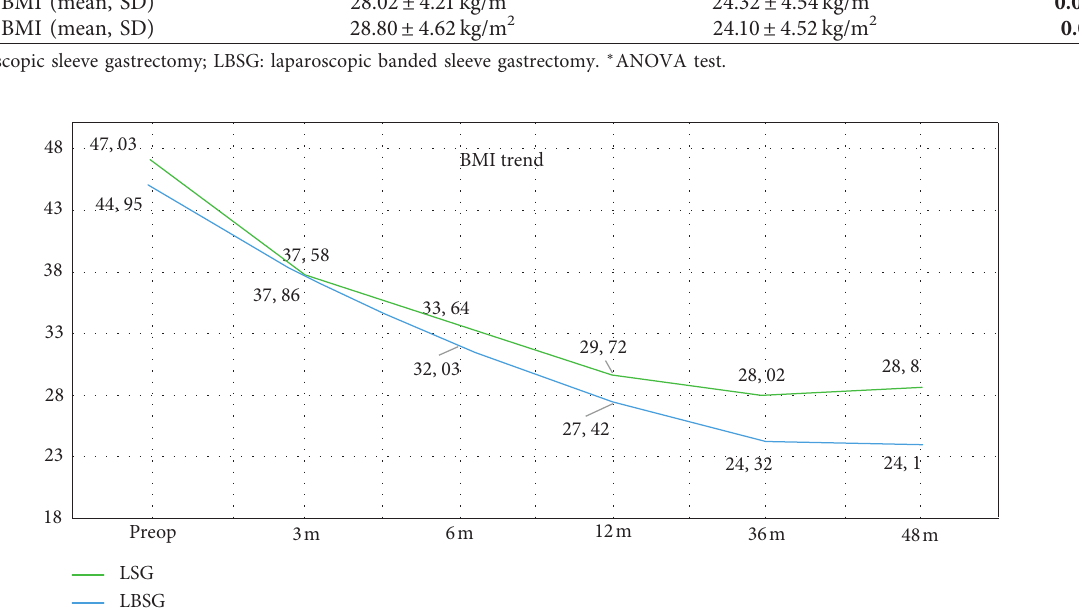
Figure 2: Variation of mean BMI during the follow-up. LSG: laparoscopic sleeve gastrectomy; LBSG: laparoscopic banded sleeve